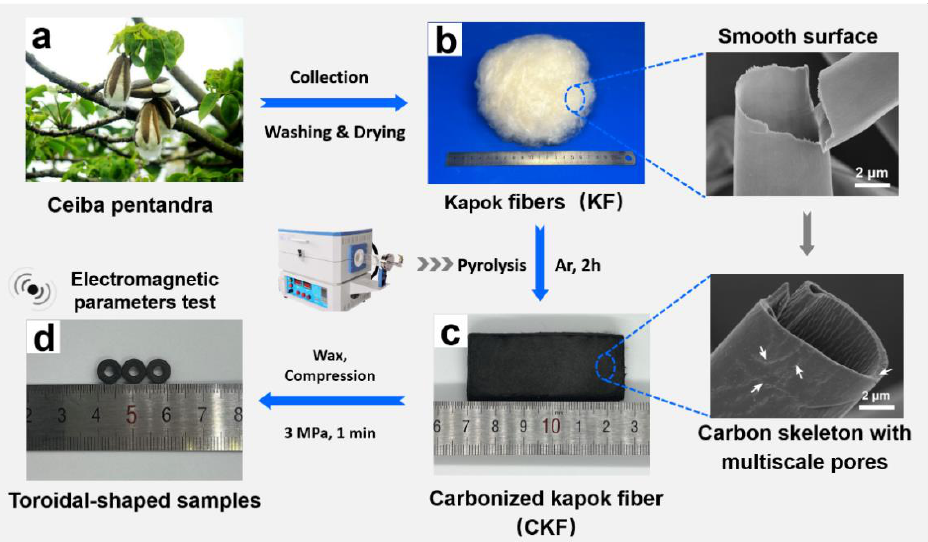
Figure 1. Schematic illustration of the preparation of kapok-derived carbon microtube.